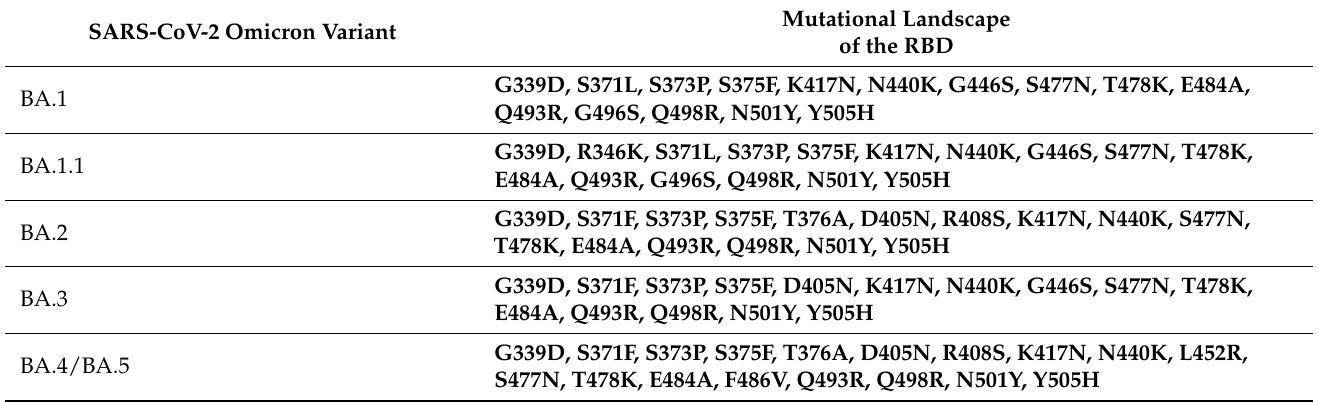
Table 1. Mutational landscape of the Omicron subvariants in the